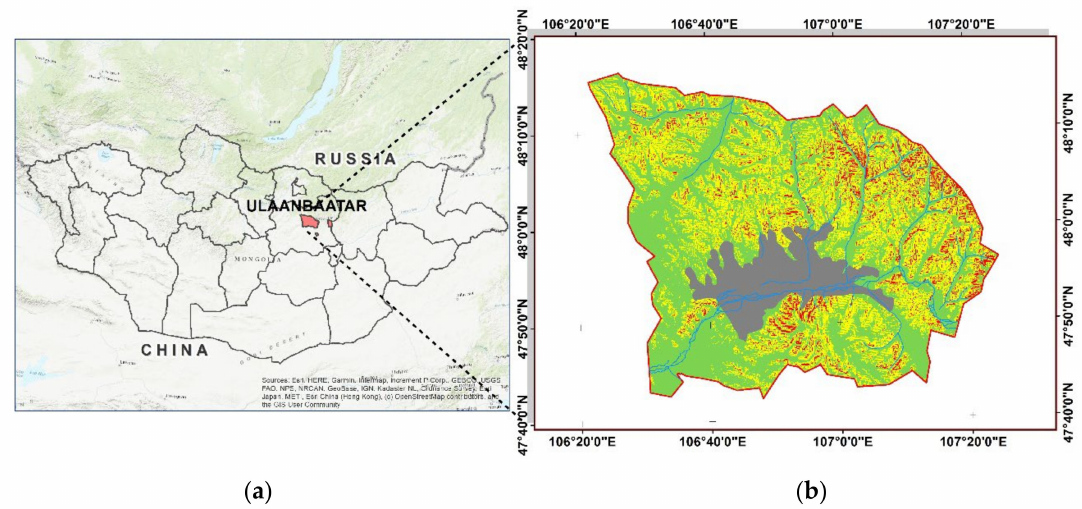
Figure 2. Map of the study area. ( a ) Location of Ulaanbaatar city; ( b ) area suitable for settlement.